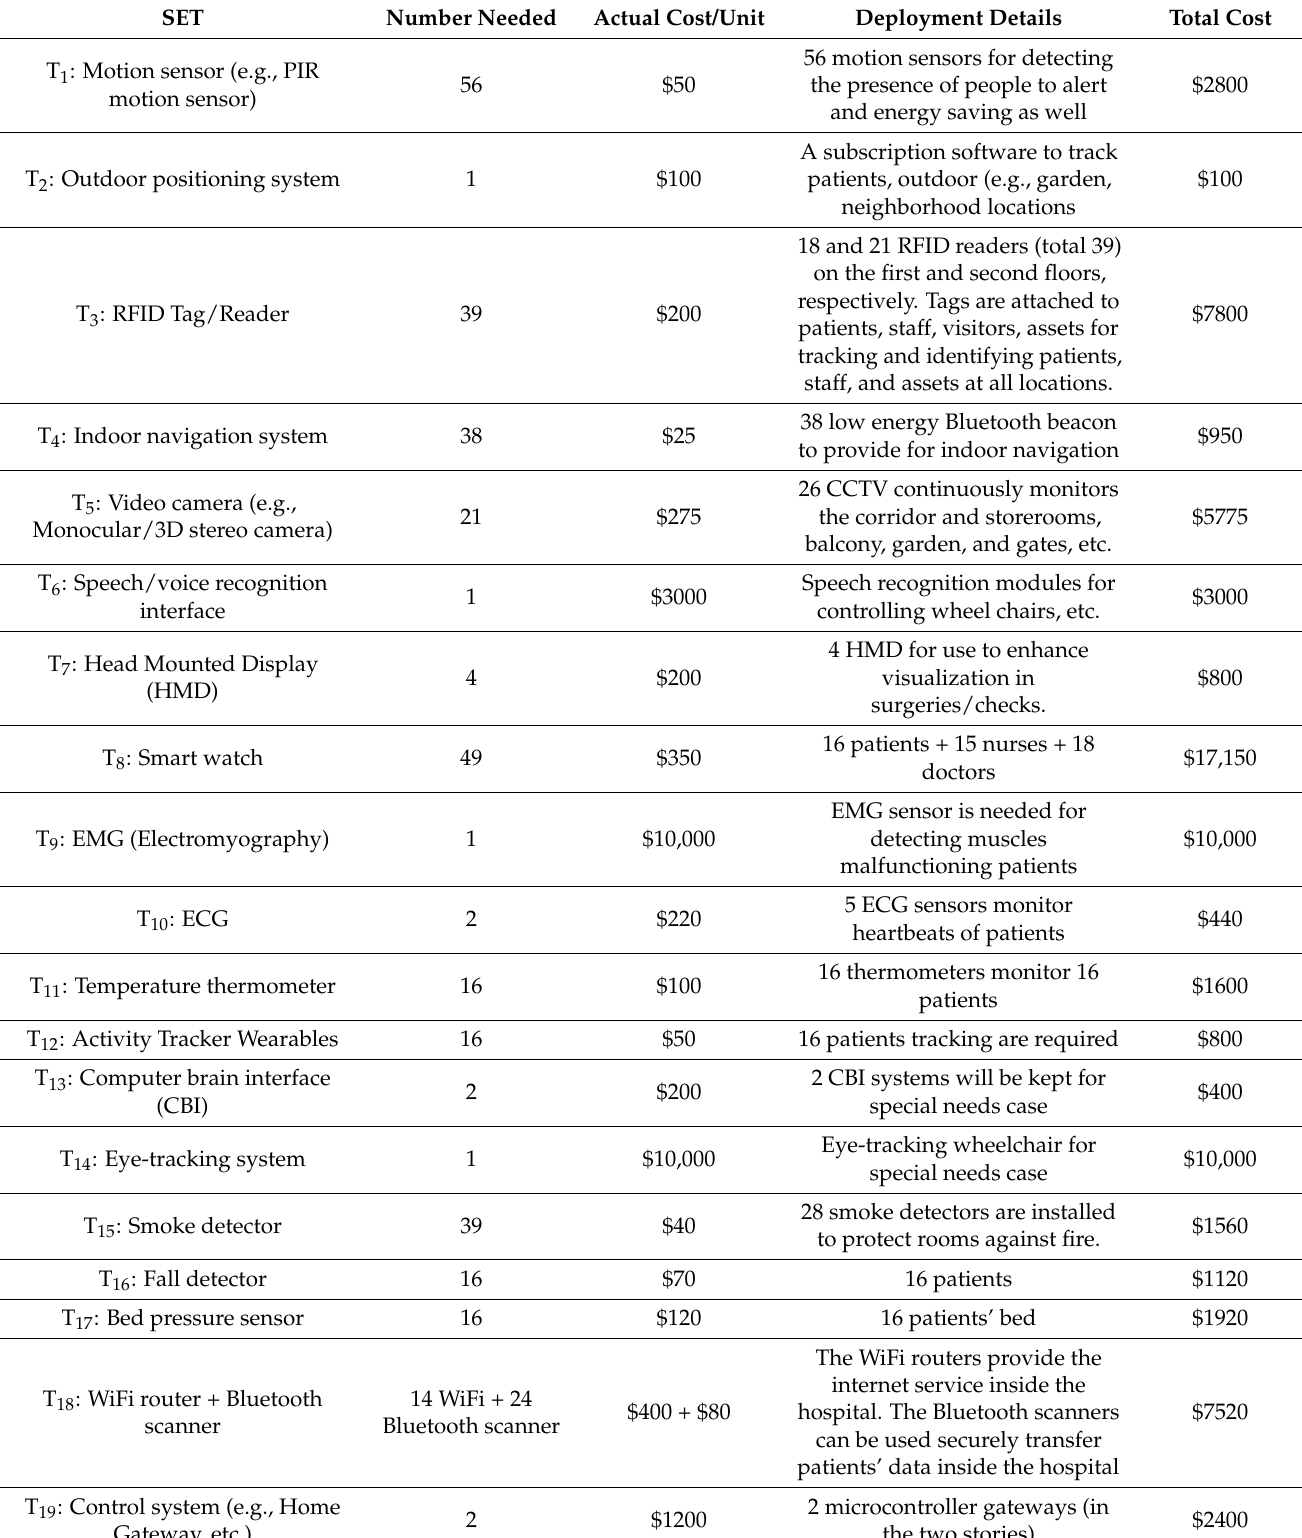
Table 8. The cost implication of SETs deployment